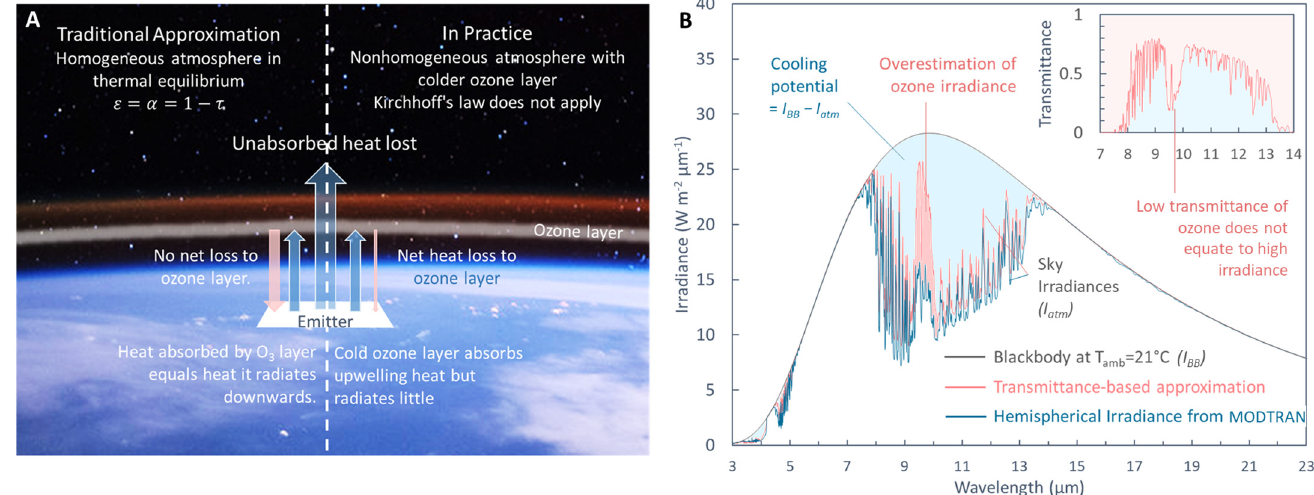
Figure 1. ( A ) Conceptual framework for traditional atmospheric thermal radiation against real case atmospheric thermal radiation. The photograph in the background was taken by NASA [31], and used under the Creative Commons-CC-BY-NC-ND 2.0 License. ( B ) The spectral hemispherical atmospheric irradiance from the transmittance-based approximation and that from MODTRAN.